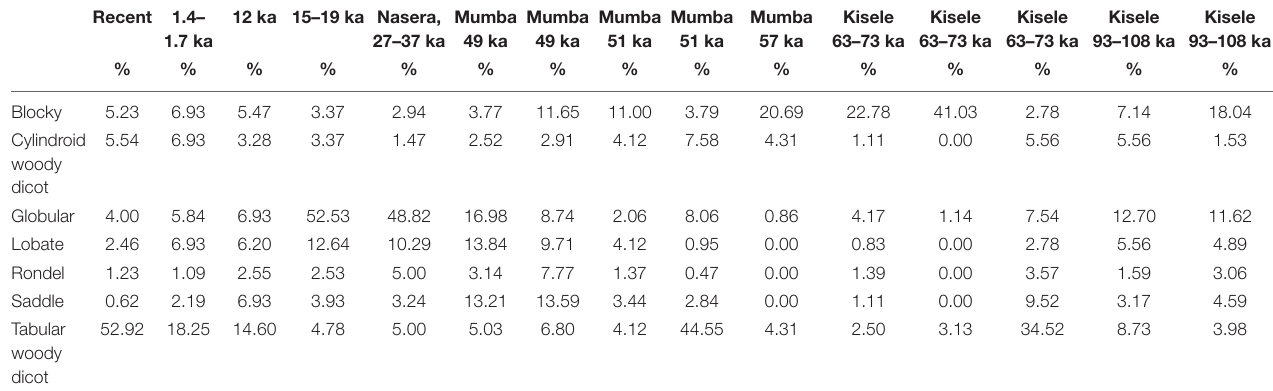
TABLE 3 | Main phytolith classes per archaeological phase.